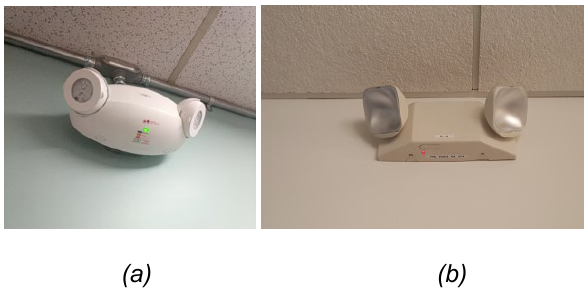
Figure 6: Emergency lights from Round 4: (a) Evans Hall, (b) Cory